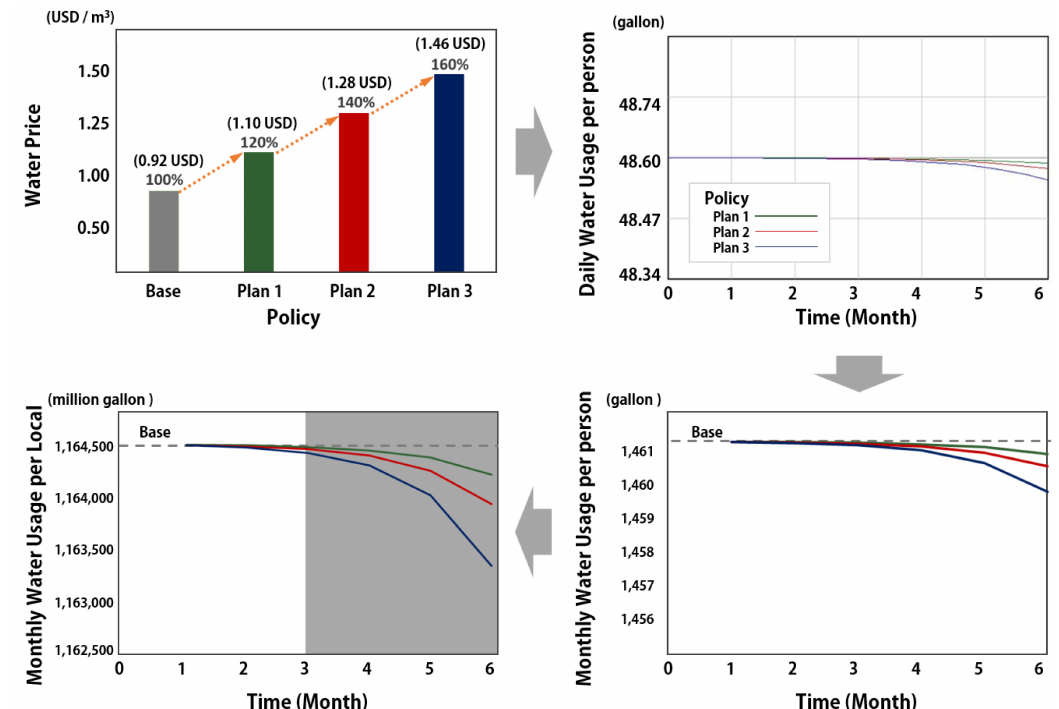
Figure 6. Changes in the amount of the water demand by increased water rate.